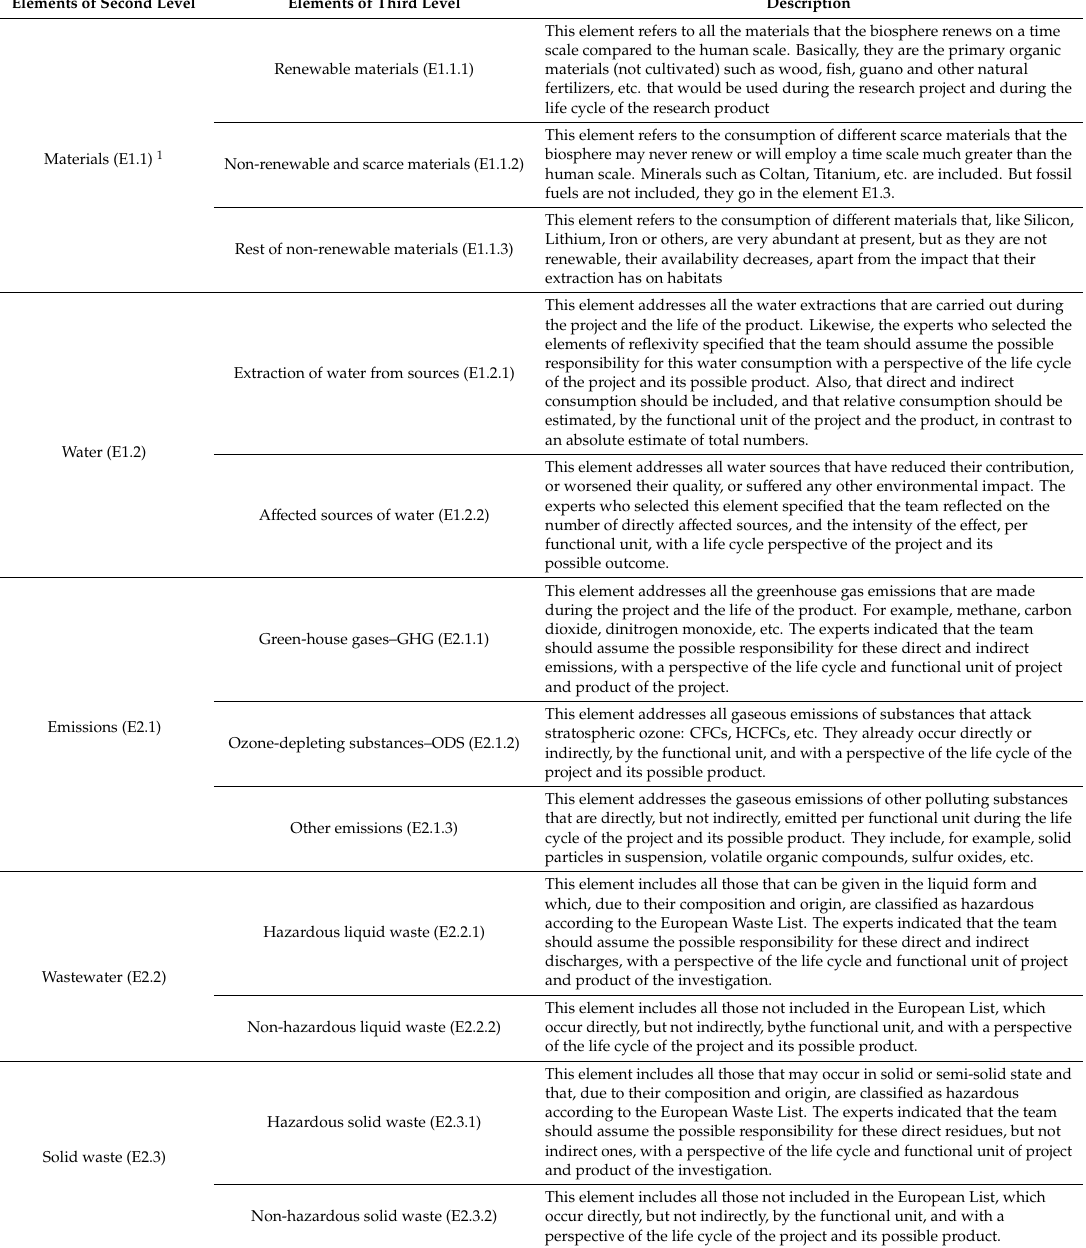
Table A4. Description of the elements of the third